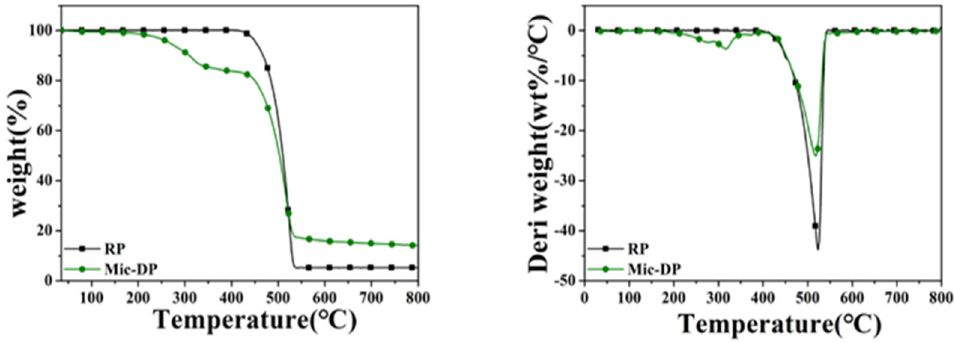
Figure 3. TG ( left ) and DTG ( right ) curve of RP and Mic − DP.